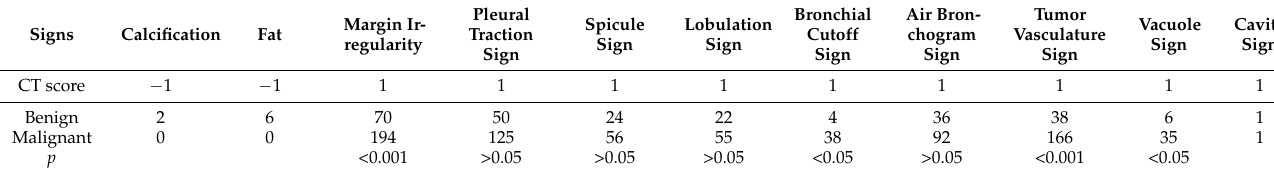
Table 4. Distribution of CT signs and CT score of each sign.